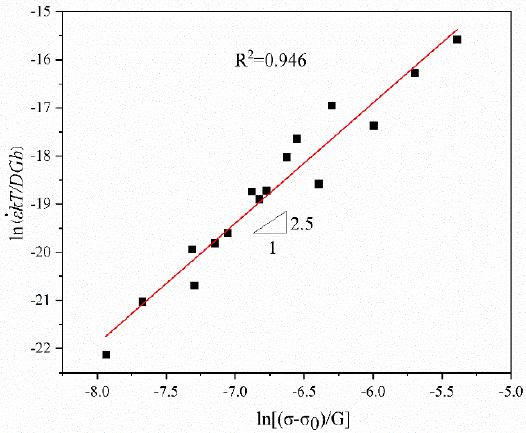
(cid:0) . (cid:1) − ε kT / DGb ln [( σ − σ 0 ) / G ] . The black squares are data